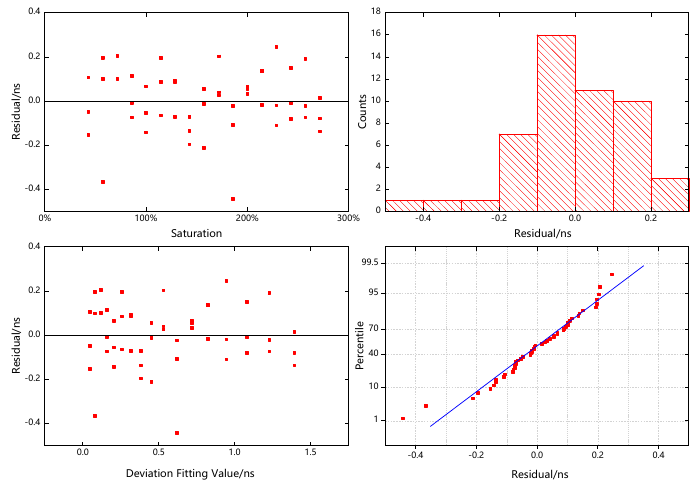
Figure 13. Residual plots of the laser signal reception time deviation model, which are composed of the residual plot with the independent variable as abscissa ( upper left ), the residual plot with the fitted value of the dependent variable as abscissa ( lower left ), the histogram of the residuals ( upper right ), and the normal probability plot of the residuals ( lower right ).